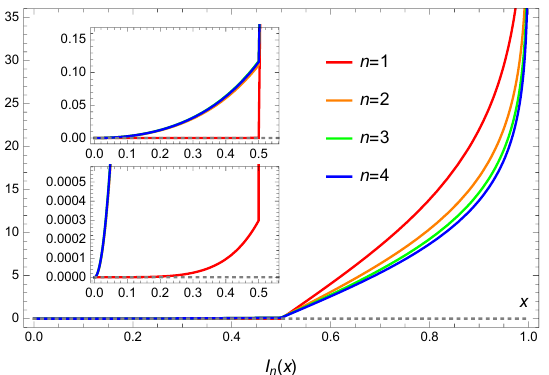
Figure 5 . The R(cid:19)enyi mutual information of two disjoint intervals on a complex plane with cross ratio x in the 2D large c CFT. To draw the (cid:12)gure we have set c =